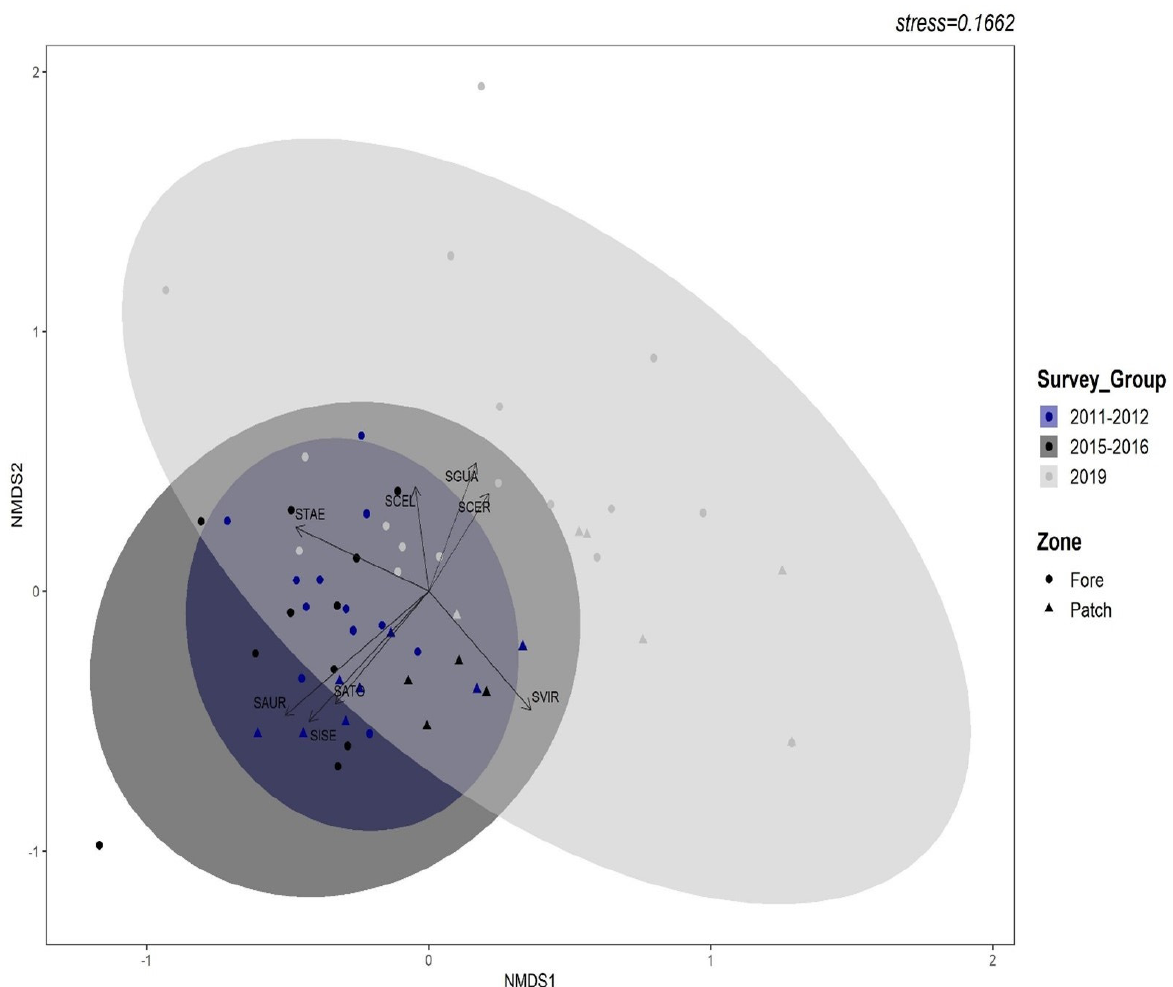
Figure 3. Non-metric multidimensional scaling (NMDS) plots describing the assemblage-level variation of mean densities of parrotfish species from New Providence by survey period and zone. Points indicate parrotfish assemblages at individual sites, with species densities averaged for all transects from each survey group. Sites are labeled by zone and colored by survey group. Ellipses represent 95% confidence intervals for parrotfish assemblages associated with each survey group and the stress values indicate a measure of distortion due to the representation of ordinations in two-dimensional space of the assemblages. Species abbreviations are as follows: SCHR = Sp. Chrysopterum ; SGUA = Sc. Guacamaia ; SCEL = Sc. coelestinus ; SRUB = Sp. rubripinne ; STAE = Sc. taeniopterus ; SVET = Sc. vetula ; SAUR = Sp. aurofrenatum ; SISE = Sc. iseri ; SVIR = Sp. viride ; SATO = Sp. Atomarium; and SCER = Sc. coeruleus .